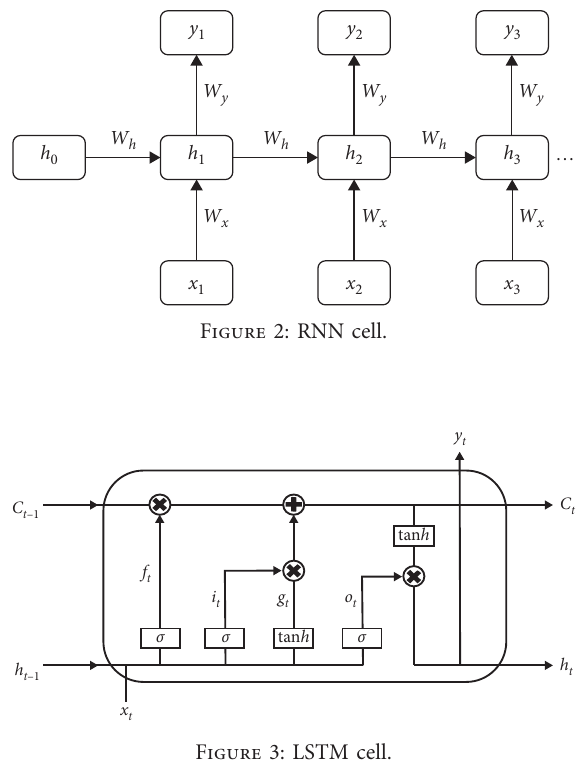
Table 2: Summary of kernels.